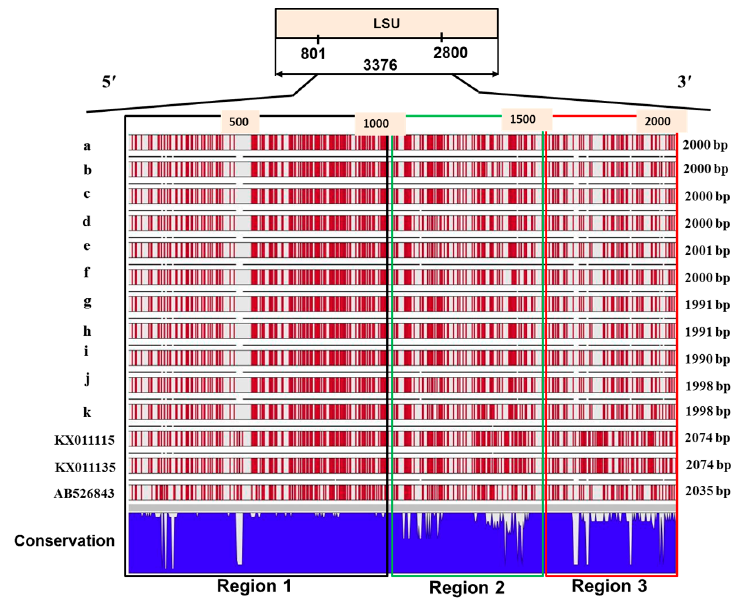
Figure 4. Variations in the sequences of the large subunit (between 801–2800 bp) in the 11 Korean geographical isolates of P. brassicae, the Japanese isolate AB526843 and two European isolates KX011115 and KX011135. Red bars and white spaces (expect gaps in annotations) represent the locations of GC and AT bases, respectively. Gaps in annotation indicate insertion-deletion (InDel) in sequences compared to consensus sequence. White gaps in conservation indicate sequence dissimilarity among isolates. a, Gangneung1; b, Yeoncheon; c, Daejon; d, Haenam2; e, Seosan; f, Pyeongchang; g, Gangneung2; h, Haenam1; i, Hoengseong; j, Geumsan; and k, Goesan.